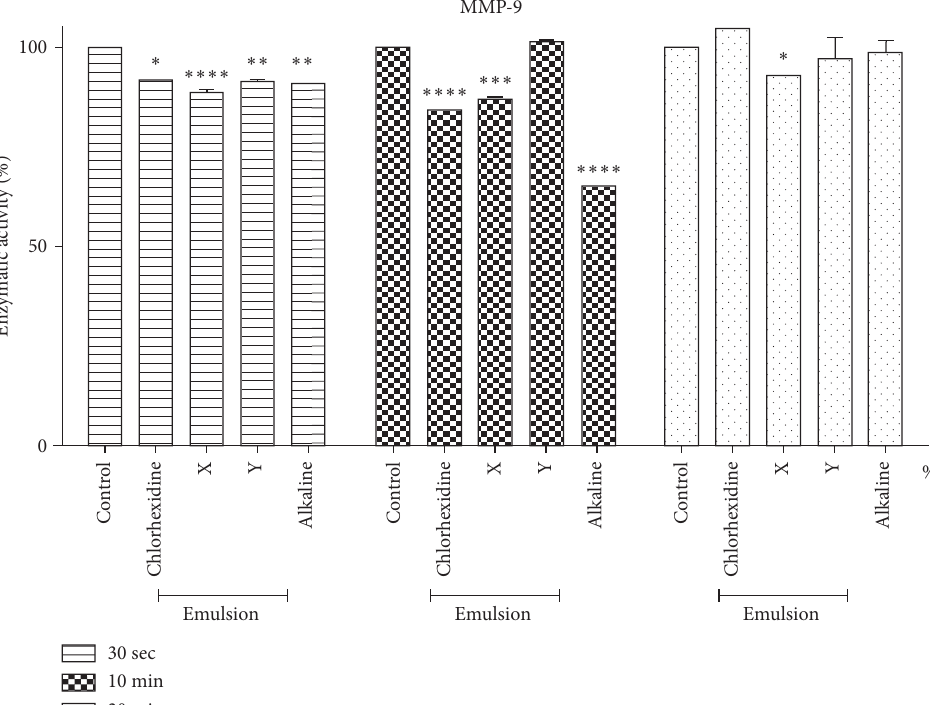
Figure 3: AnalysisoftheenzymeactivityofMMP-9comparedtotreatmentswithatestedsolution.Itshows,over30seconds,astatisticaldifferencein thedecreaseinMMP-9activityamongalltestedsolutionswhencomparedtothecontrolgroupwithouttreatment.In10minutes,therewasastatistical difference only between CLX, EC+X, and alkaline EC. At 20 minutes, the only solution that showed a significant difference in decreasing MMP-9 activity was